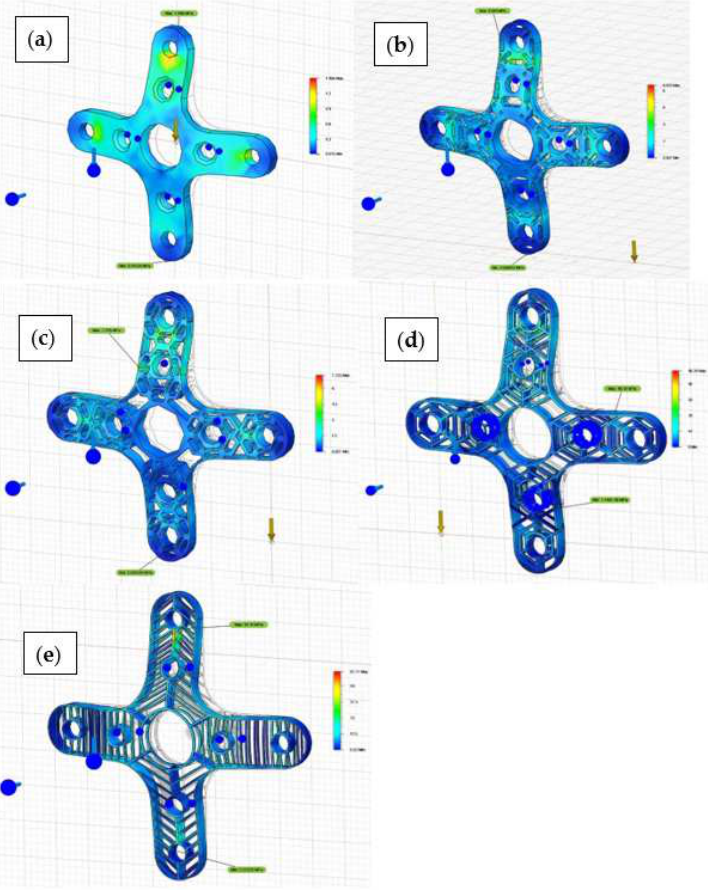
Figure 12. FEA static stress analysis of ( a ) original holder, ( b ) polyhedral, ( c ) snowflake, ( d ) circular spiderweb, and ( e ) linear spiderweb.